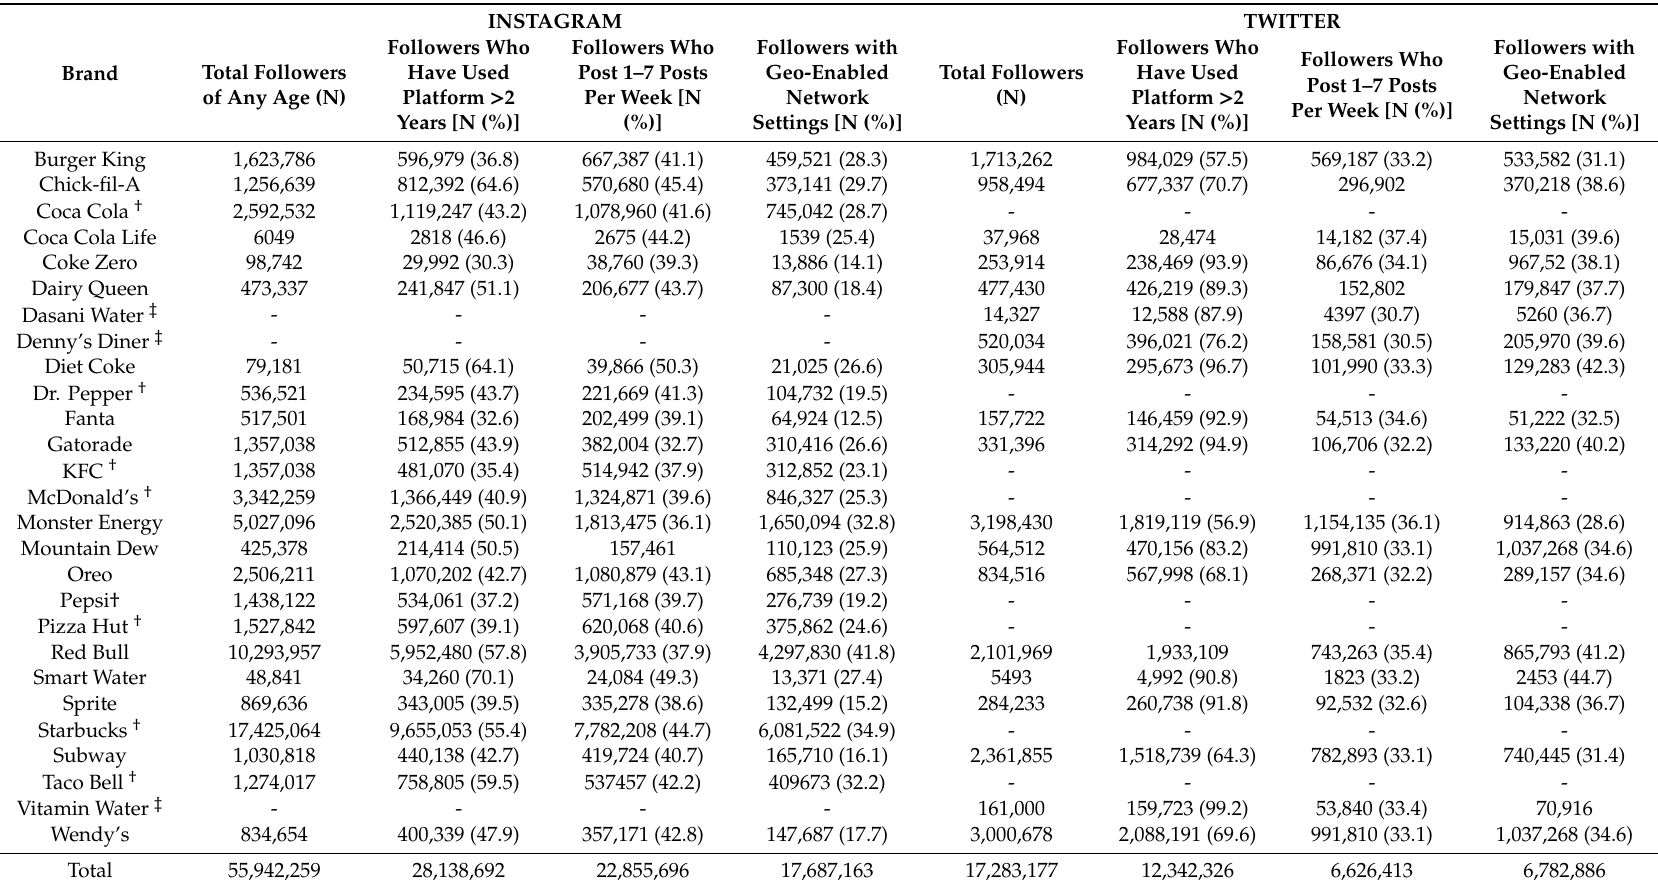
Table 1. Total numbers of followers of popular food and beverage brands ( n = 27), by social media platform and user characteristics,